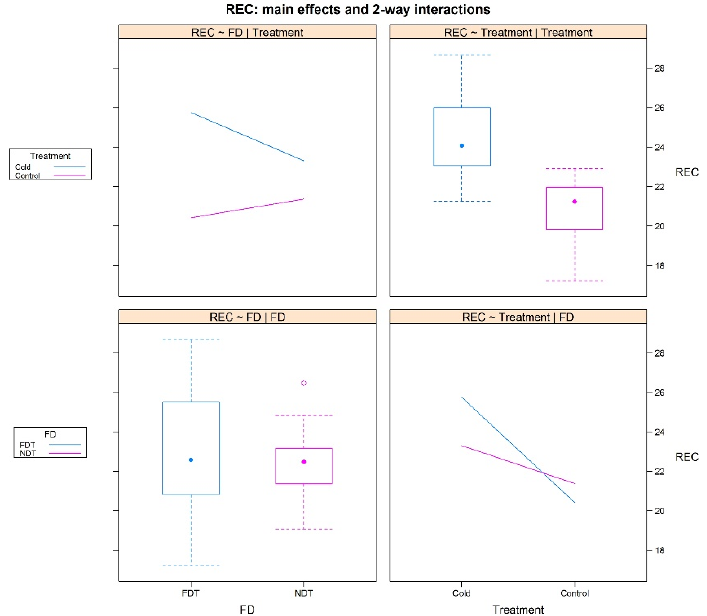
Figure 1. Summary of two-way ANOVA results of alfalfa REC based on FD and cold stress. Note: The ANOVA results shows that cold stress has a significant effect on REC, while FD is not. However, FD and cold stress have an interactive effect on REC in alfalfa, FDT alfalfa have lower REC levels than NDT ones with normal condition, while FDT types present higher REC levels under cold stress. The X -axis represents groups, including the FD group and Treatment group, while the Y -axis represents the REC value.